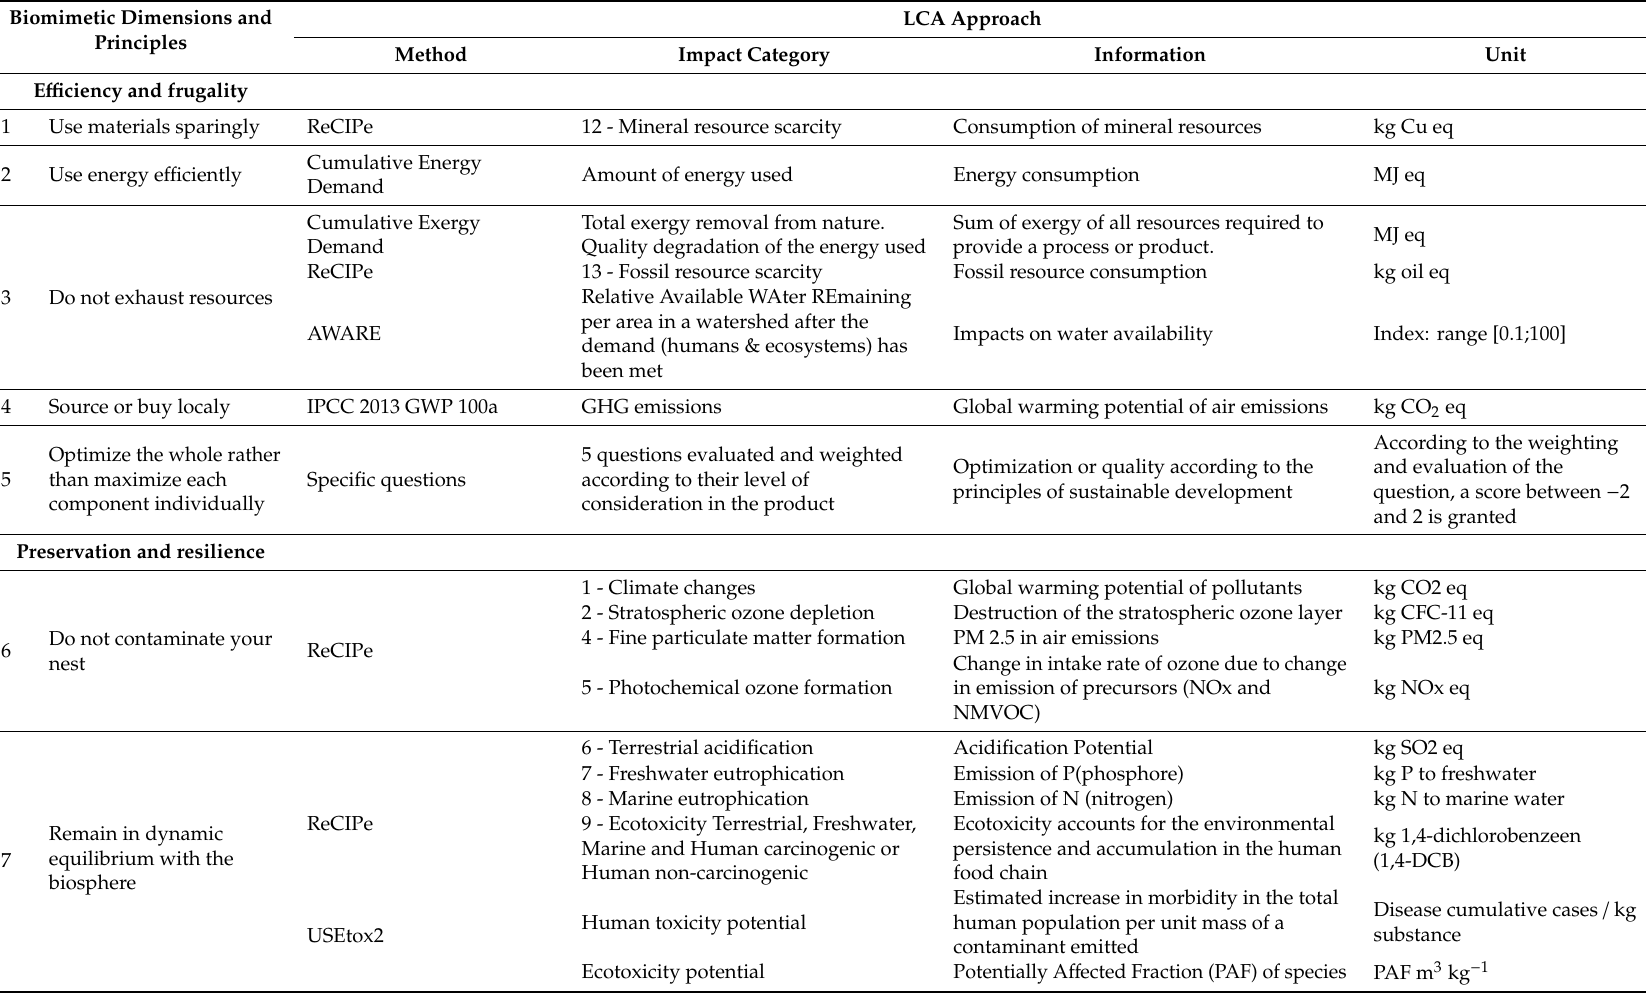
Table 1. Main impact assessment methods used for biomiMETRIC assistance tool and their association with the “Life’s Principles”. Biomimetic Dimensions and